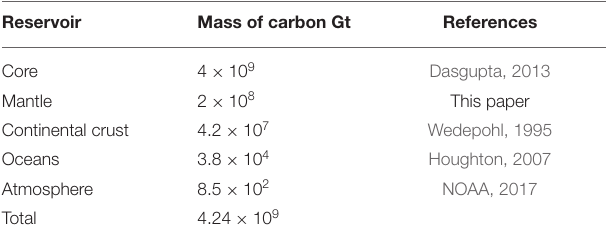
TABLE 1 | Masses of carbon in the Earth’s carbon reservoirs considered in this paper (1 Gt = 10 12 kg).